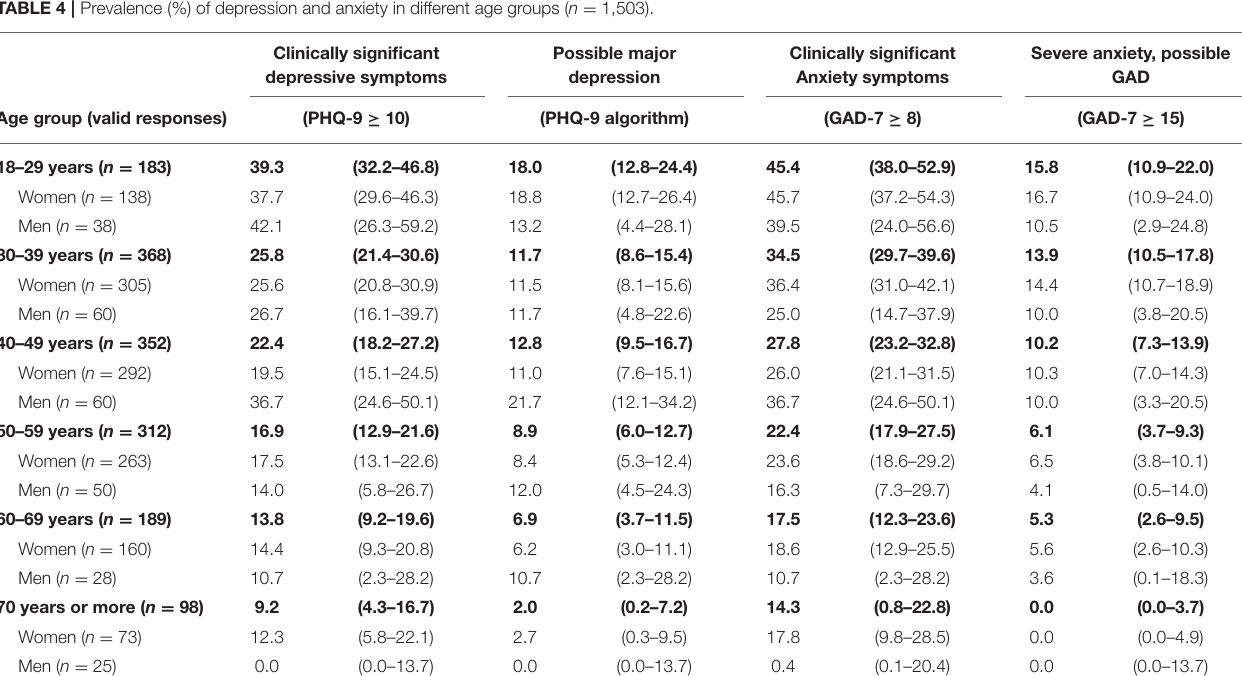
Depression PHQ-9